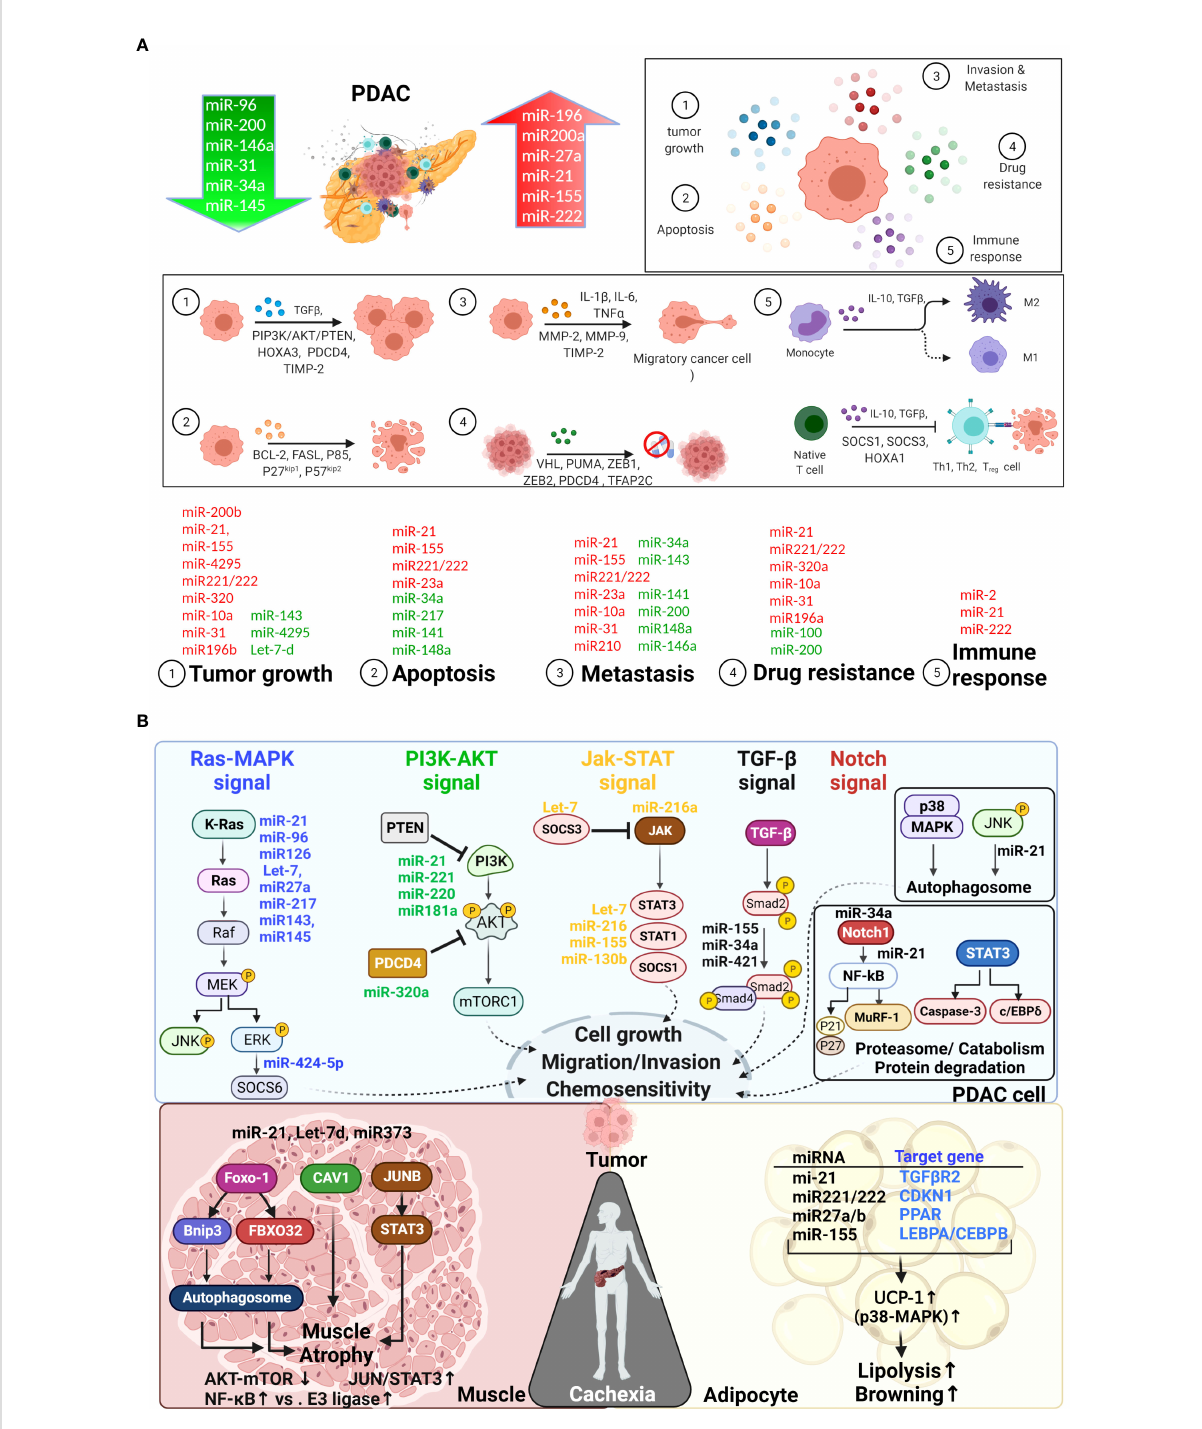
FIGURE 6 Mechanistic role of miRNAs in PDAC cachexia. (A) Downregulated microRNAs (miRNAs) are indicated in green, and upregulated miRNAs are indicated in red. Based on the literature, miRNAs participate in the regulation of PDAC progression and metastasis, overcoming host immune responses, and the development of chemoresistance. (B) . miRNAs associated with PDAC-CC are primarily involved in KRAS-MAPK, PI3K-AKT, JAK-STAT, and TGF- b , NF- k B and p38-MAPK signaling pathway … etc. miRNAs can be detected in tumor and serum and mediate crosstalk in the tumor microenvironment between tumor, muscle, and adipocytes, which are associated with the development of PDAC-CC. Some microRNAs are tissue speci fi c. For example, miR-21 (TLR7-JUN), miR-155, let-7d and miR373 are speci fi c contributed to muscle wasting in PDAC-CC (see Table 6 in detail). The most common genes, such as IL-6R, FOXO1, PDK4, and ZIP14, had been associated with muscle wasting in cachexia. In adipocytes, speci fi c microRNAs may mediate the transcription factors C/EBP b / d , C/EBP a , and PPAR g , resulting in